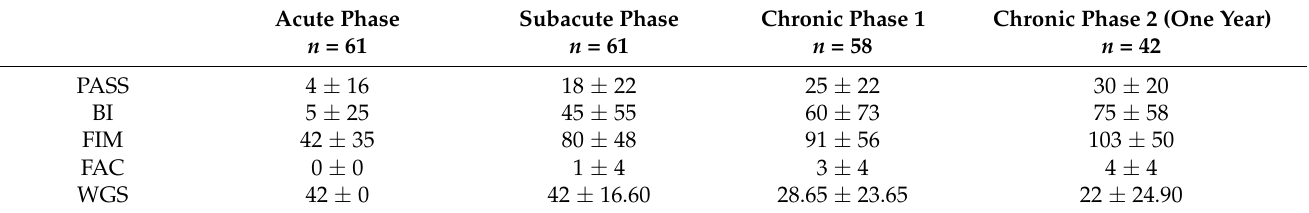
Table 3. Scoring in acute, subacute and chronic